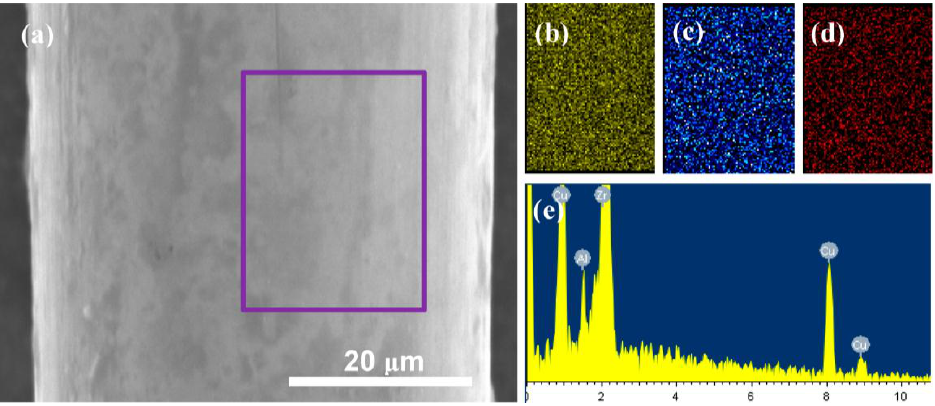
Figure 3. SEM and energy dispersive spectroscopy (EDS) analysis of Cu 48 Zr 48 Al 4 amorphous microwire. ( a ) Morphology of microwire. ( b – d ) Elements distributions of Zr, Cu, and Al, respectively. ( e ) Energy spectrum of